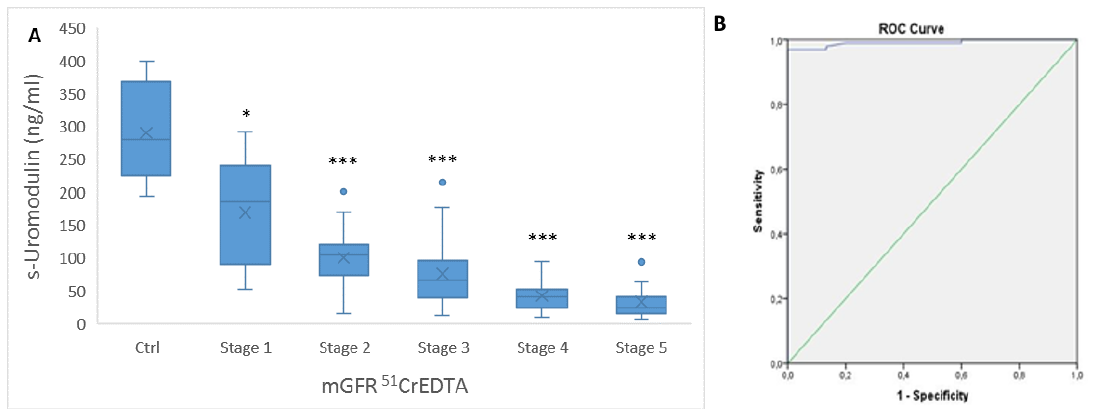
Figure 2. Uromodulin concentration in serum. ( A ) The boxplots for serum uromodulin concentration (s-Uromodulin) in chronic kidney disease of transplanted kidney (CKD-T) stages 1–5 based on measured GFR with 51 CrEDTA (mGFR 51 CrEDTA) (stage 1, n = 5; stage 2, n = 21; stage 3, n = 43; stage 4, n = 17; and stage 5, n = 11, with mGFR 51 CrEDTA not possible to perform for 3 patients) in comparison to the control group (Ctrl); ( B ) ROC curve and AUC distinguishing CKD-T from the control group without any renal diseases. Legend: * p < 0.05, *** p < 0.001 (Ctrl versus Stage 1–5). Table 1. Bivariate correlations between serum uromodulin concentration (s-Uromodulin) and parameters of kidney graft function: serum creatinine concentration (s-Creatinine), serum cystatin C concentration (s-CysC), serum urea concentration (s-Urea), estimated glomerular filtration rate with Chronic Kidney Disease Epidemiology Collaboration study formula with s-Creatinine (eGFR CKD EPI creatinine), estimated glomerular filtration rate with Chronic Kidney Disease Epidemiology Collaboration study formula with s-CysC (eGFR CKD EPI CysC), estimated glomerular filtration rate with Chronic Kidney Disease Epidemiology Collaboration study formula with s-Creatinine and s-CysC (eGFR CKD EPI creatinine CysC) and measured GFR with Chromium-51-ethylenediaminetetraacetic acid (mGFR 51